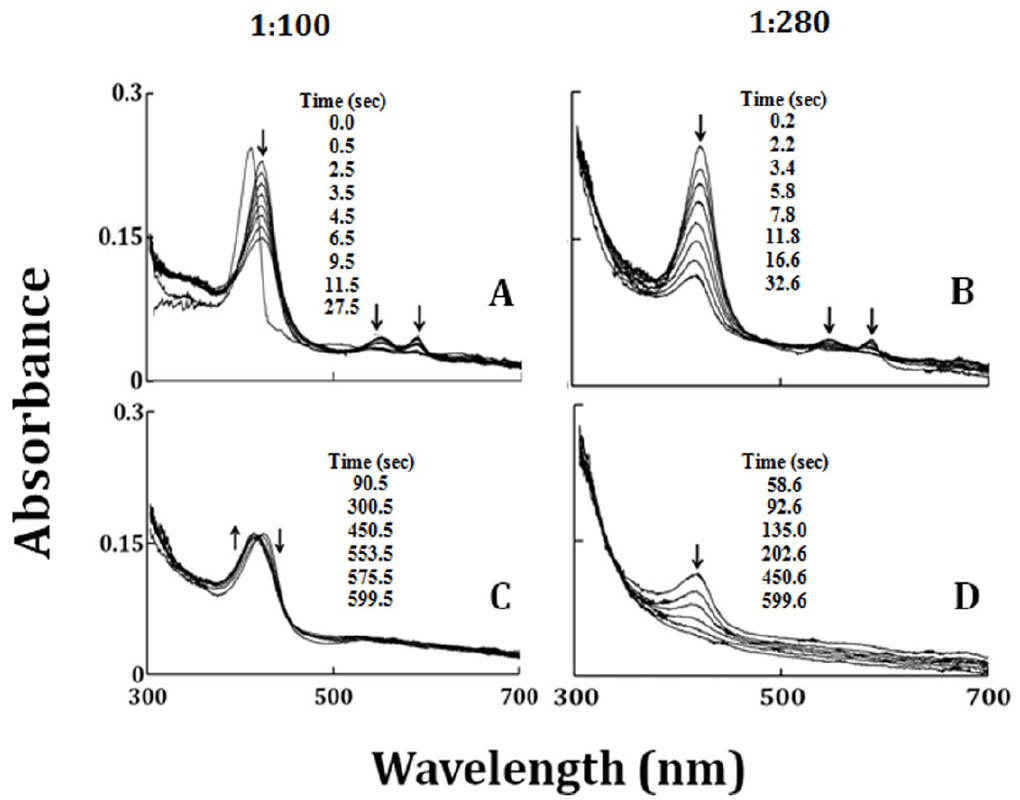
Figure 3. Diode array spectral changes for the reaction of LPO compound III with increasing concentration of HOCl. Rapid-scanning diode array spectra were recorded during the reaction of LPO Compound III (3 m M) with a buffer solution containing 300 m M (Panels A and B) and 840 m M (Panels and G, H, and I) HOCl, at 10 u C. Arrows in the panels indicate the direction of spectral changes over time. The time of each collected spectrum after initiation of the reaction is indicated in seconds. The dashed line spectrum is the spectra of the LPO-Fe(III). The first spectrum corresponds with the initial formation of Compound III, which was generated by mixing LPO-Fe(III) with 200 m M H 2 O 2 . The experiments shown are representative of